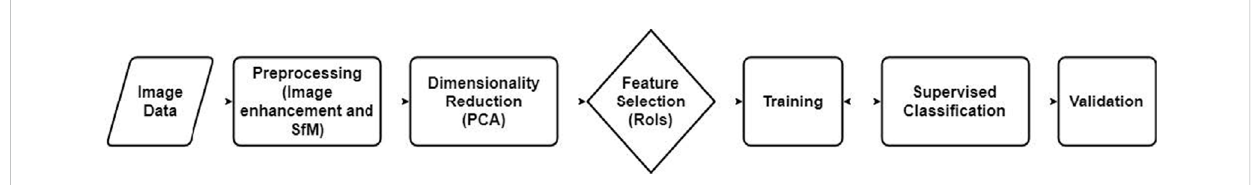
FIGURE 2 Flowchart of image processing